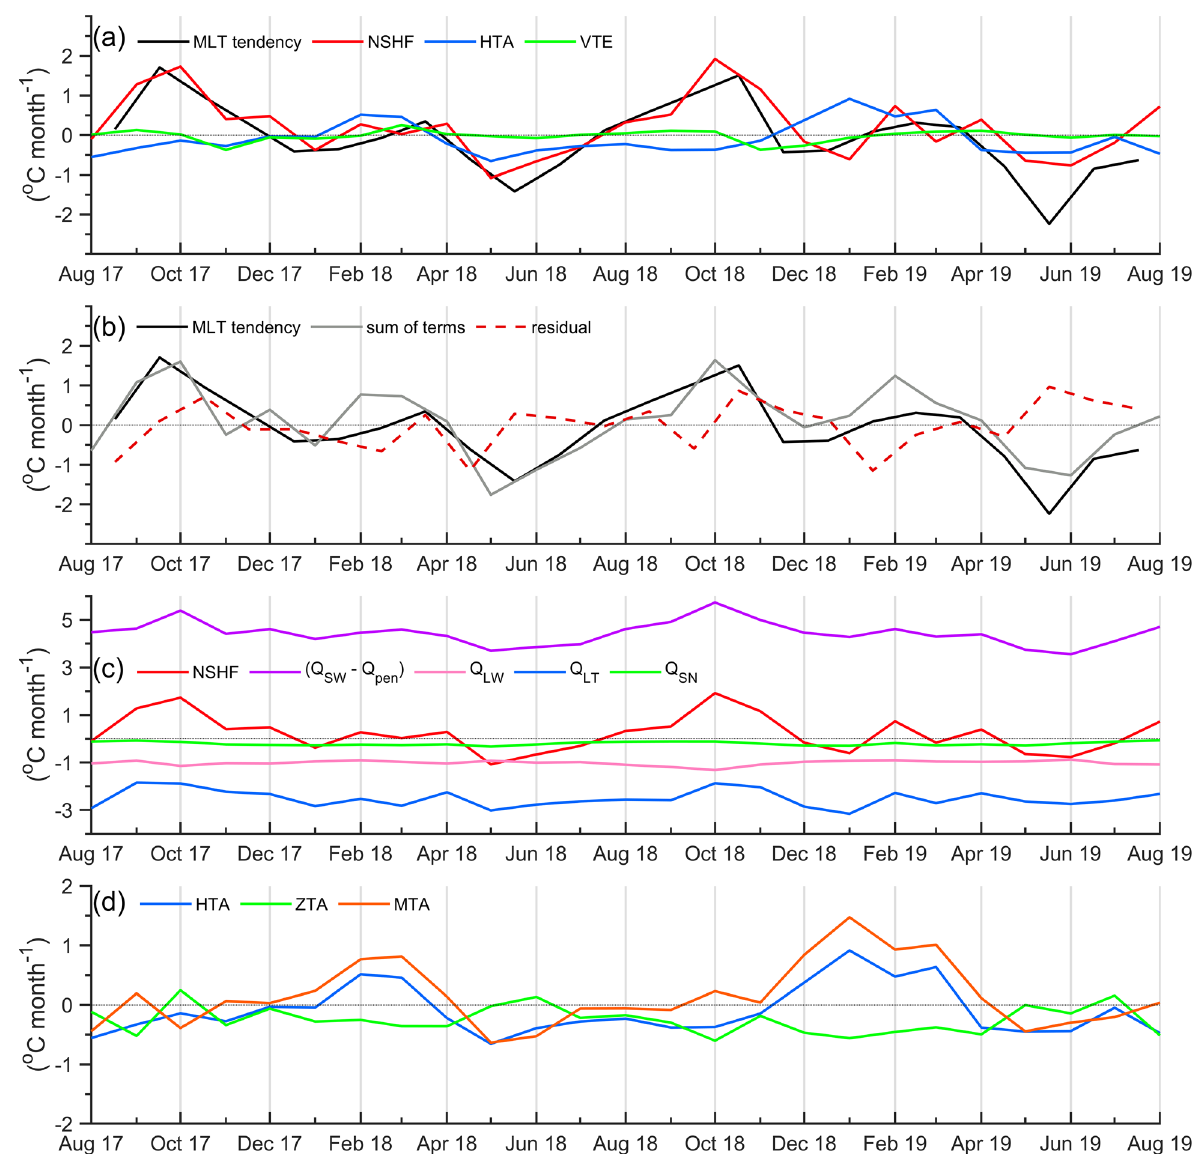
Fig. 2 a Temporal evolution of the MLT balance (°C month − 1 ). MLT tendency (black line), net surface heat flux (NSHF (red line), horizontal temperature advection (HTA; blue line), and vertical temperature entrainment (VTE; green line). b MLT tendency (black line), sum of MLT balance terms (grey line), and residual (red dashed line). c Decomposition of NSHF into net shortwave radiation (Q SW ) minus the fraction of shortwave radiation that escapes through the base of the MLD (Q pen ; purple line), net longwave radiation (Q LW ; pink line), net latent heat flux (Q LT ; blue line) and net sensible heat flux (Q SN ; green line). d Decomposition of HTA into zonal temperature advection (ZTA; green line) and meridional temperature advection (MTA; orange